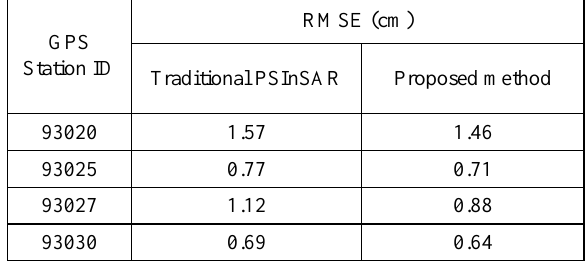
Table 2. RMSEs of land deformation of GPS